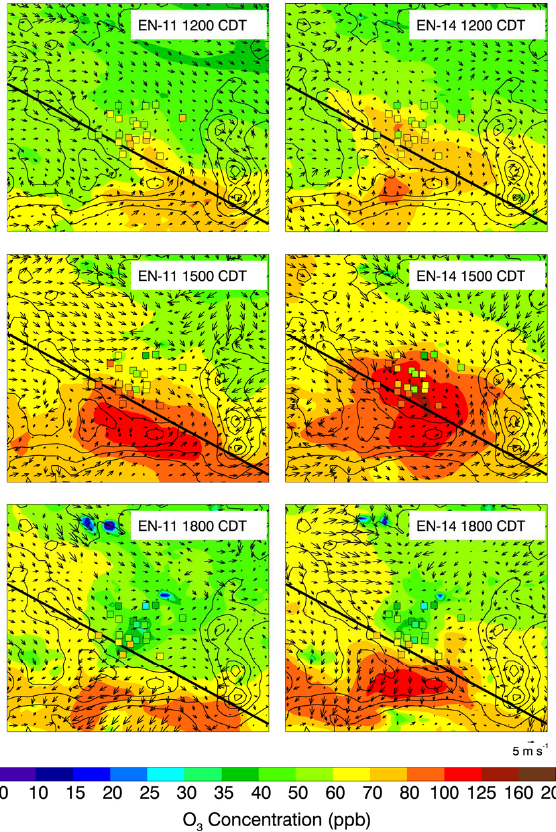
Fig. 8. Surface [O 3 ] of two extreme members (EN-11 and EN-14, bold green lines shown in Fig. 5a) along with surface wind vectors valid at 12:00CDT, 15:00CDT, and 18:00CDT on 3 March 2006. Cross line is the position of the cross-section shown in Fig. 9.